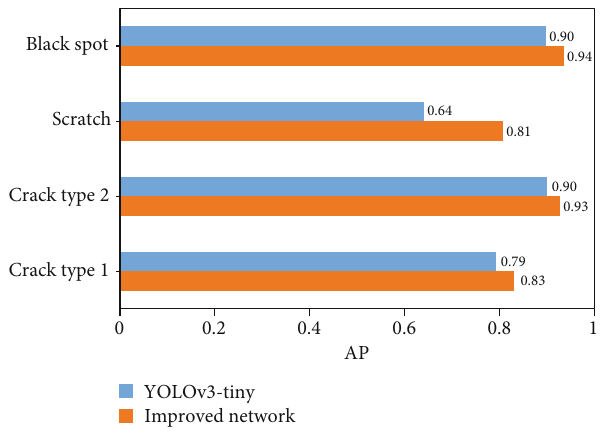
Figure 14: Comparison of AP values of the two network models on di ff erent defect types.